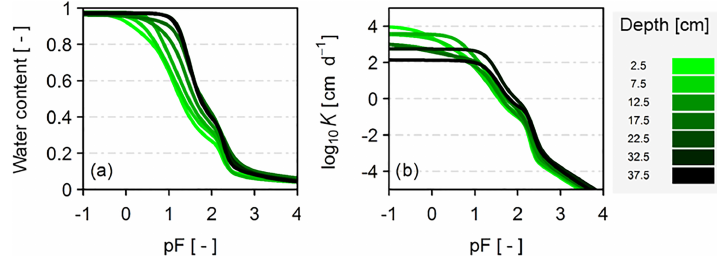
Figure 5. Mean (a) retention and (b) conductivity curves for the depths 2.5cm to 37.5cm in 5cm increments.